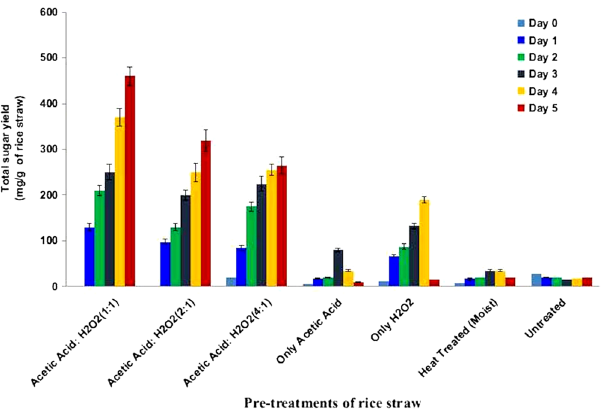
Figure 4. Saccharification of chemical and heat pretreated rice straw by RSV secretome.